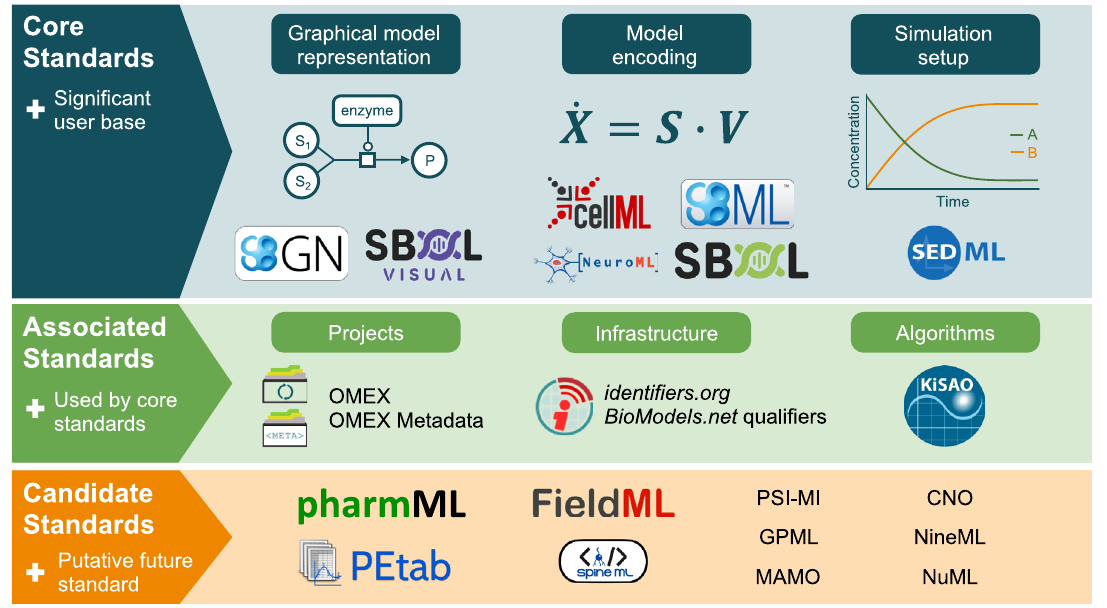
Figure 1: COMBINE standards and associated efforts (updated from [ 3